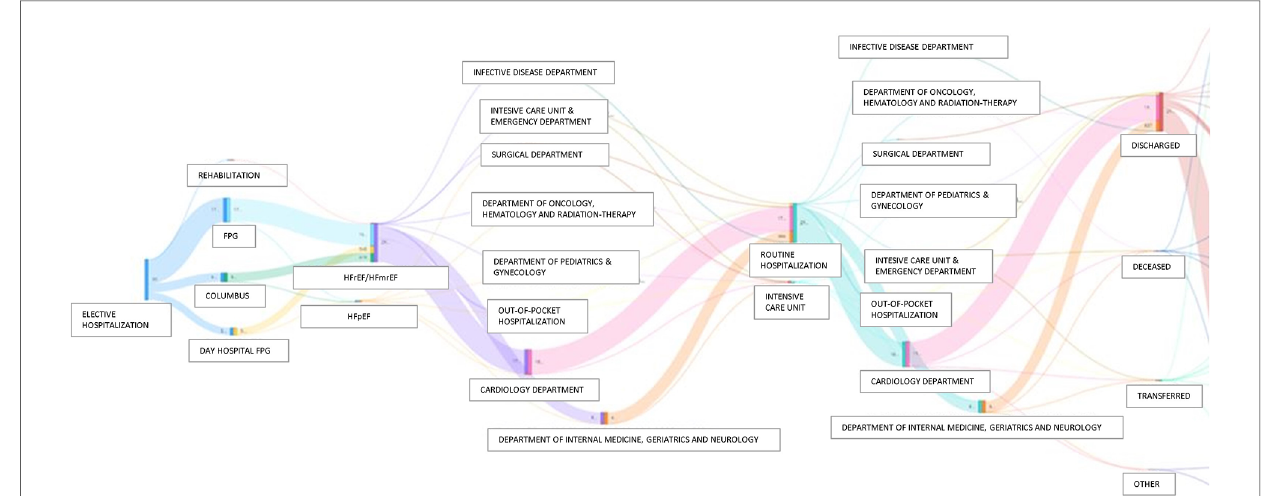
FIGURE 8 Sankey diagrams grouping HF patients according to their clinical pathways within Policlinco Gemelli between 2019 and 2021. FPG, Fondazione Policlinico Gemelli; HFpEF, Heart Failure with preserved Ejection Fraction; HFrEF, Heart Failure with reduced Ejection Fraction; HFmrEF, Heart Failure with mildy reduced Ejection